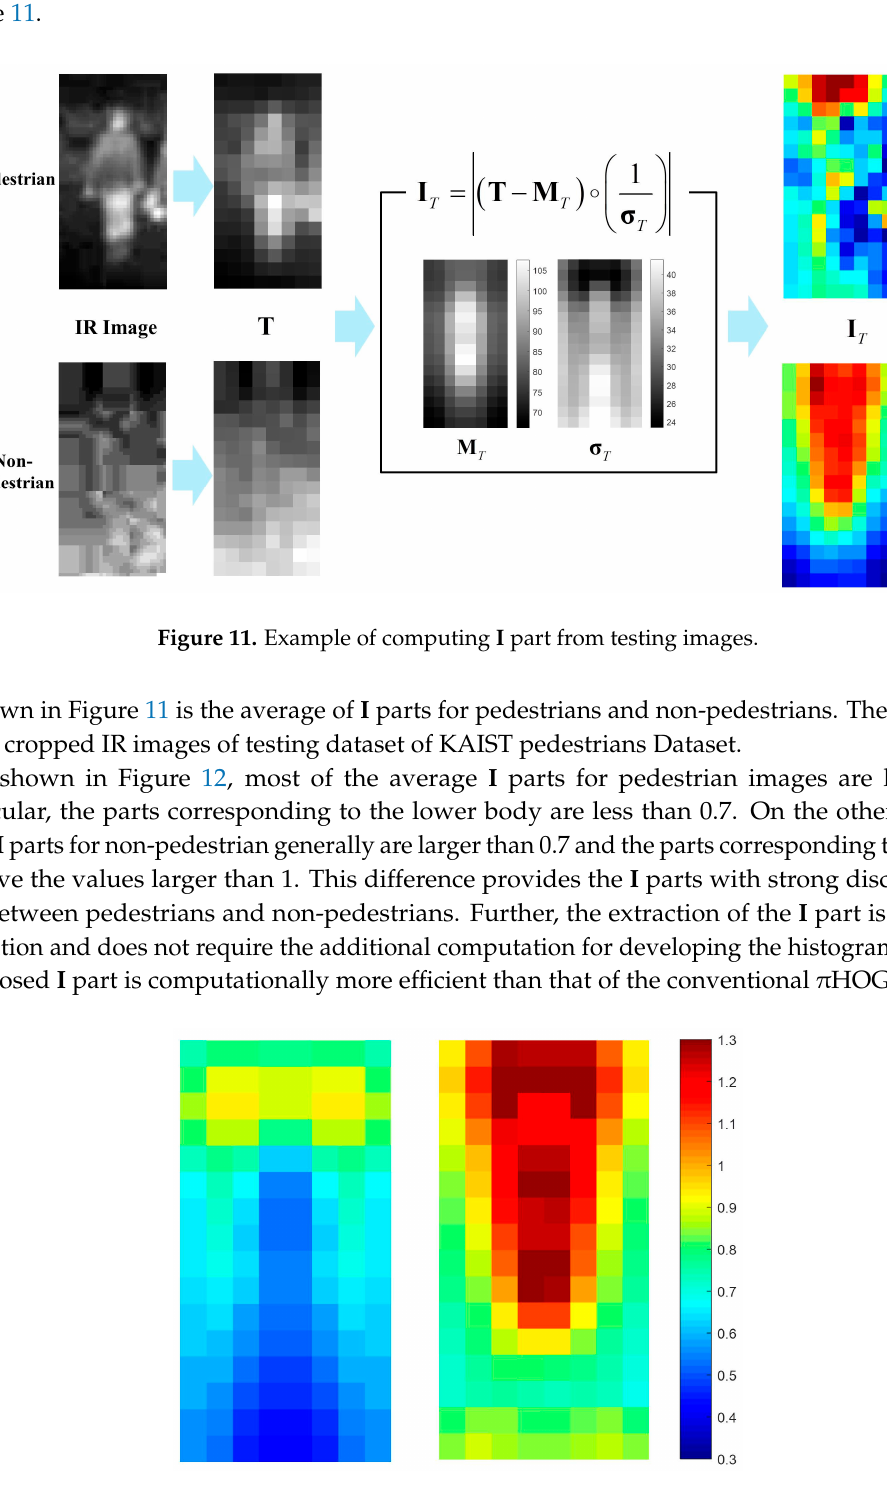
Figure 12. Average I part for testing images( Left : pedestrian, Right : non-pedestrian).